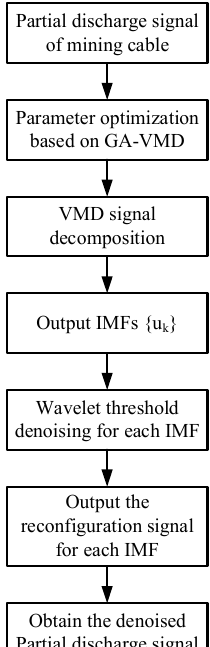
Figure 2. Denoising flow chart of PD signal.